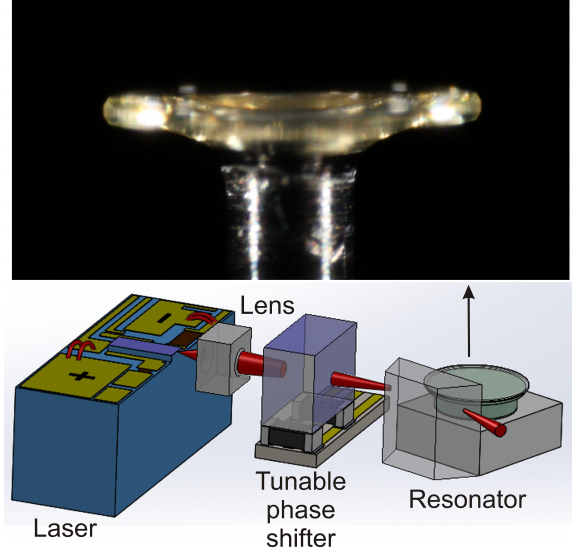
Figure 5. Schematic of the experimental